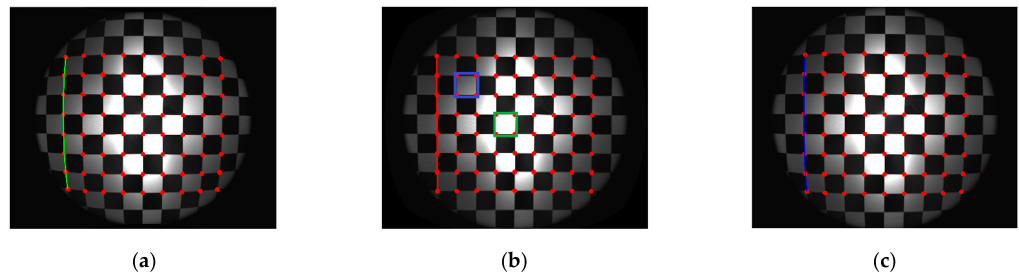
Figure 17. Experimental results of checkerboard images. ( a ) Corrected image by a one-parameter even-order polynomial model with a green line curvature radius of 6.9263 × 10 3 pixels. ( b ) Corrected image by a two-parameter even-order polynomial model with a red line curvature radius of 2.3763 × 10 4 pixels. The pixel count of the square within the central green rectangular region is 48,094 pixels, and that of the square within the external blue rectangular region is 48,694 pixels. ( c ) Corrected image by a single parameter division model with a blue line curvature radius of 1.1747 × 10 4 pixels.